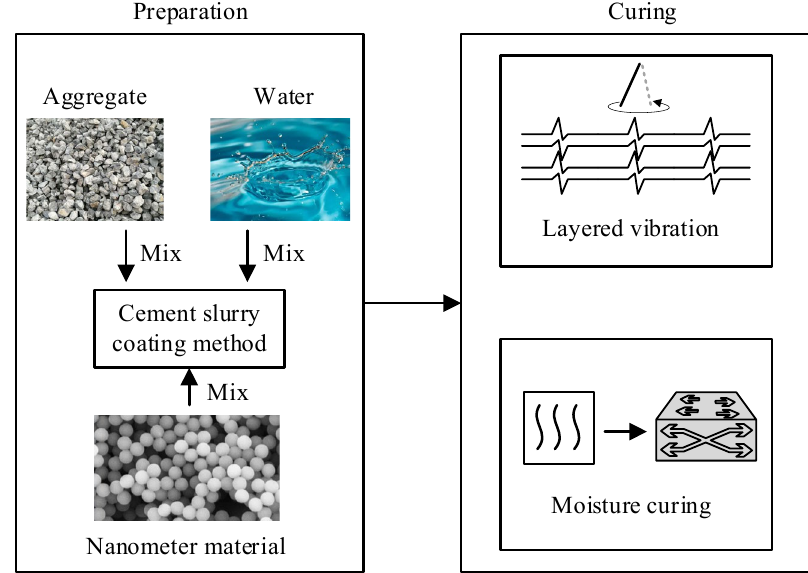
Figure 2. Preparation and curing scheme.